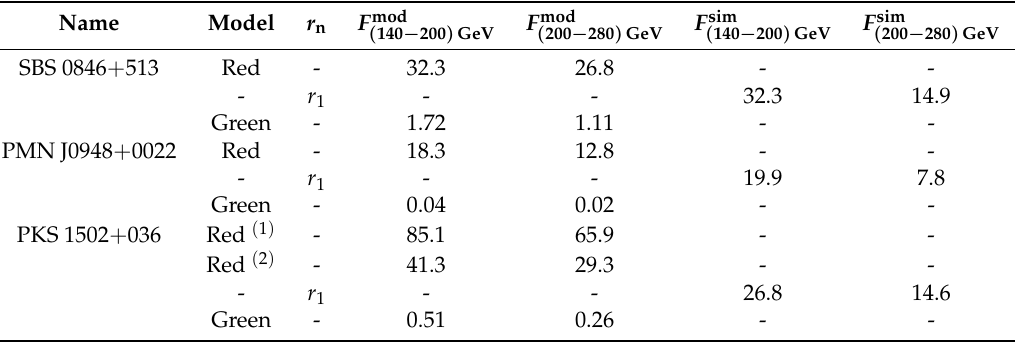
Table 2. γ -ray spectral parameters and fluxes (log-parabola models) for the three considered sources. Model refers to the red or green models in Figures 3–5. F mod in units of [10 − 13 erg cm − 2 s − 1 ], while F sim 5, and 7 of [9], same